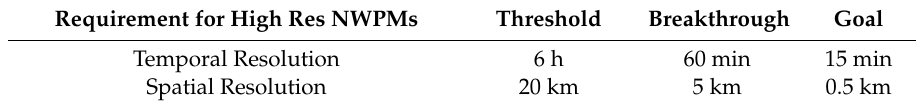
Table 1. Requirements for ingestion products into Numerical Weather Prediction Models